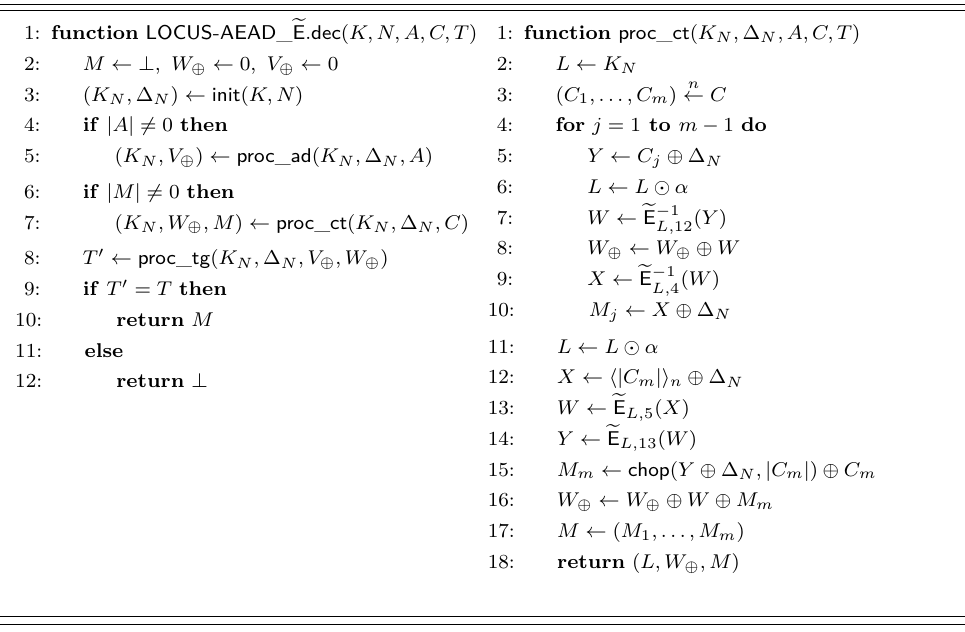
Algorithm 5 The verified decryption algorithm of LOCUS . The subroutines proc_ad and proc_tag are given in the encryption